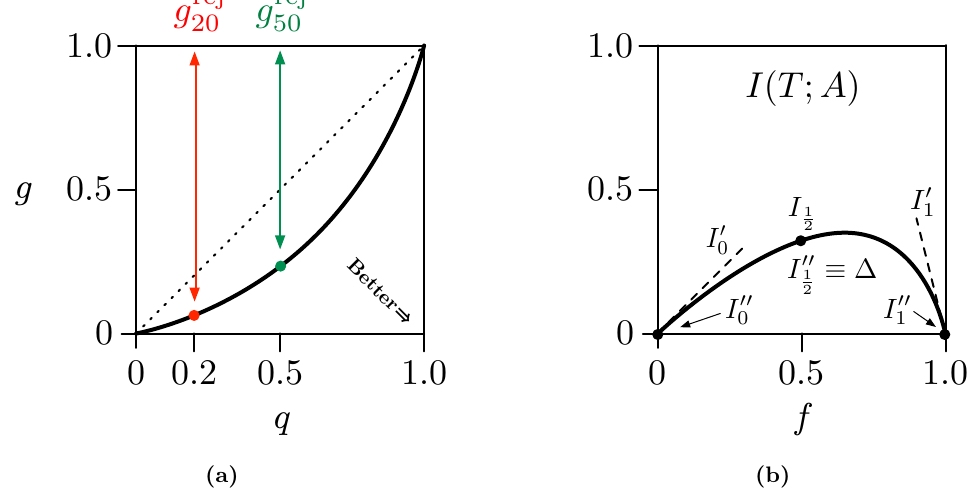
Figure 3. Alternative metrics for discrimination power. (a) A ROC curve, showing the gluon rejection rate at (cid:12)xed 20% and 50% quark e(cid:14)ciency. While not shown in this paper, some of this ROC information is available in the source (cid:12)les as supplementary material. (b) Mutual information I ( T ; A ) as a function of the quark fraction f , showing the relationship to classi(cid:12)er separation (cid:1) I 00 and other information-theoretic quantities. The mutual information at f = 1 = 2 (i.e. I 1 1 (cid:17) 2 also available in the source (cid:12)les as supplementary material of this